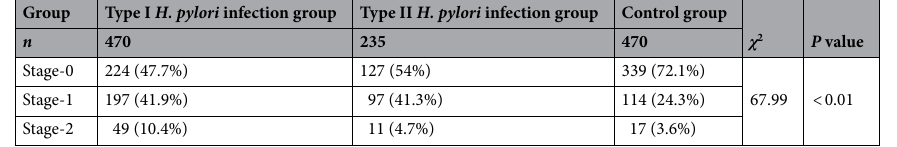
Table 2. The proportion of different types of H. pylori infection in OLGA staging.